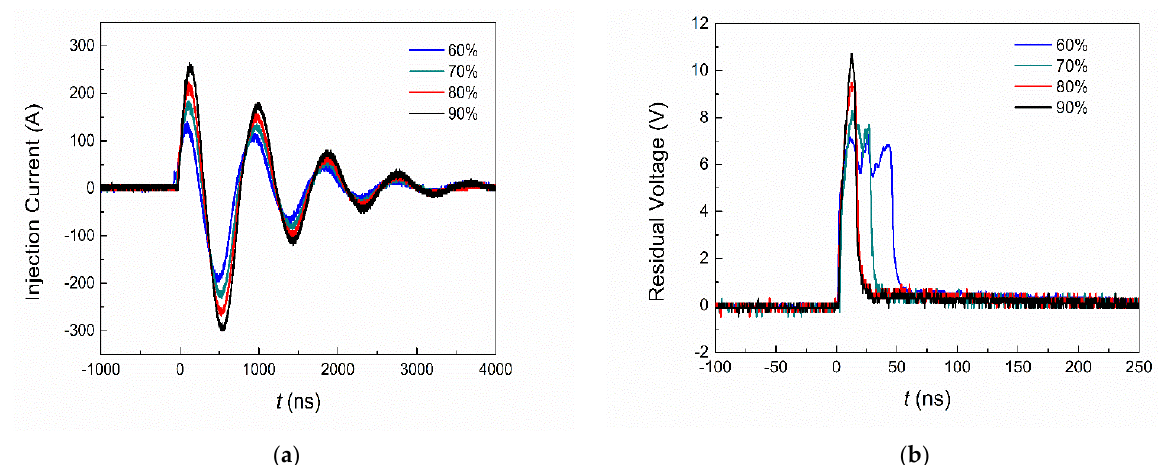
Figure 1. The measured circuit.